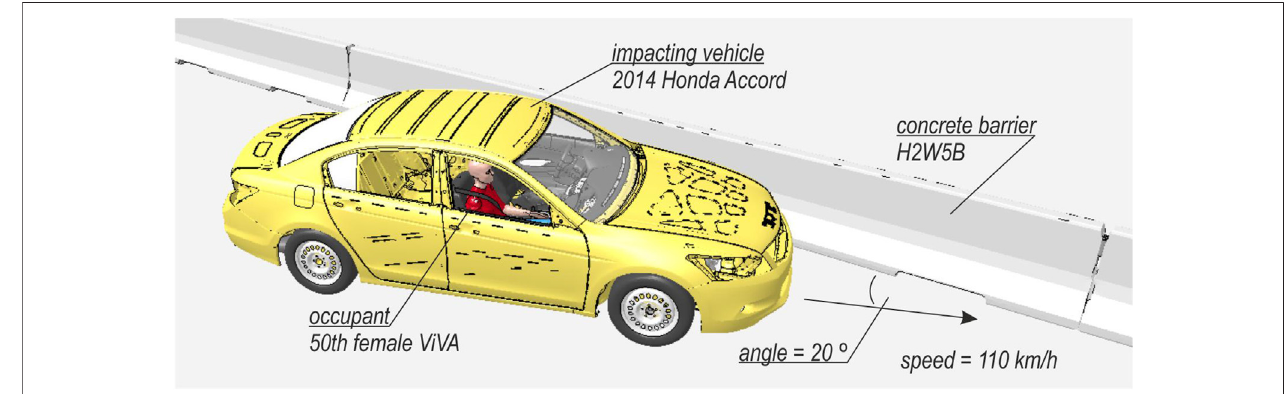
FIGURE 1 | Setup of the global collision FE